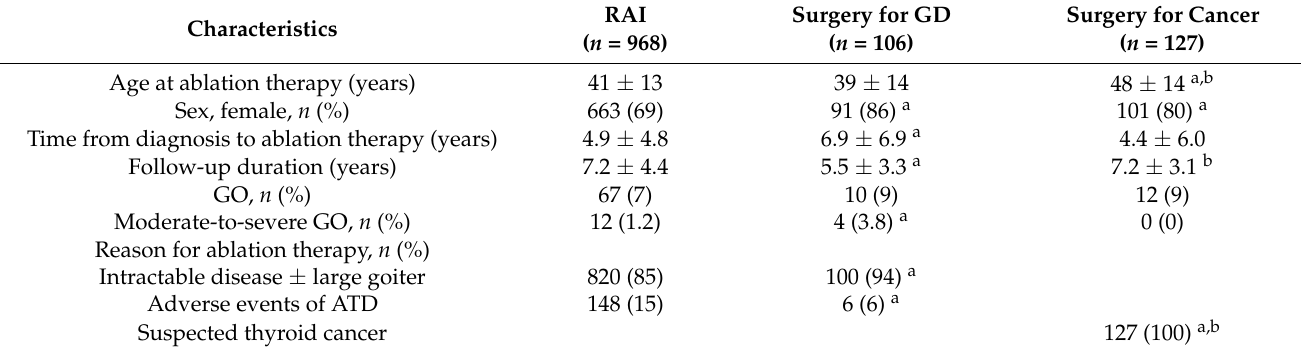
Table 2. Comparison of clinical characteristics among RAI and surgery